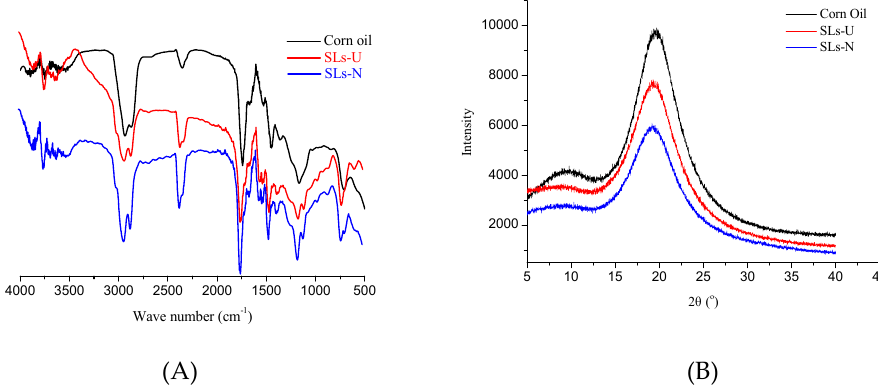
Figure 4. FTIR spectra ( A ) and X-ray spectra ( B ) of corn oil, SLs-U, and SLs-N.